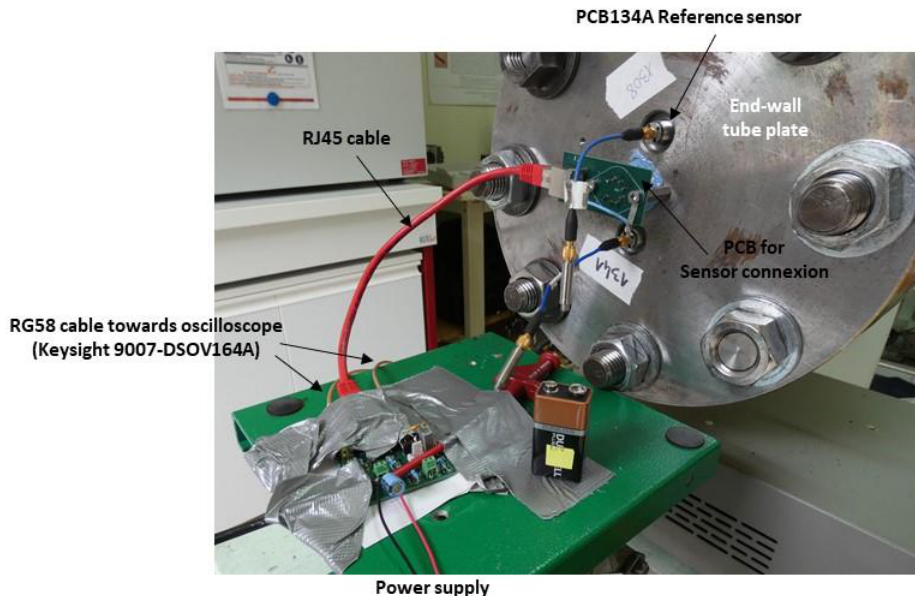
Figure 24. Experimental setup for dynamic characterization of pressure sensors.